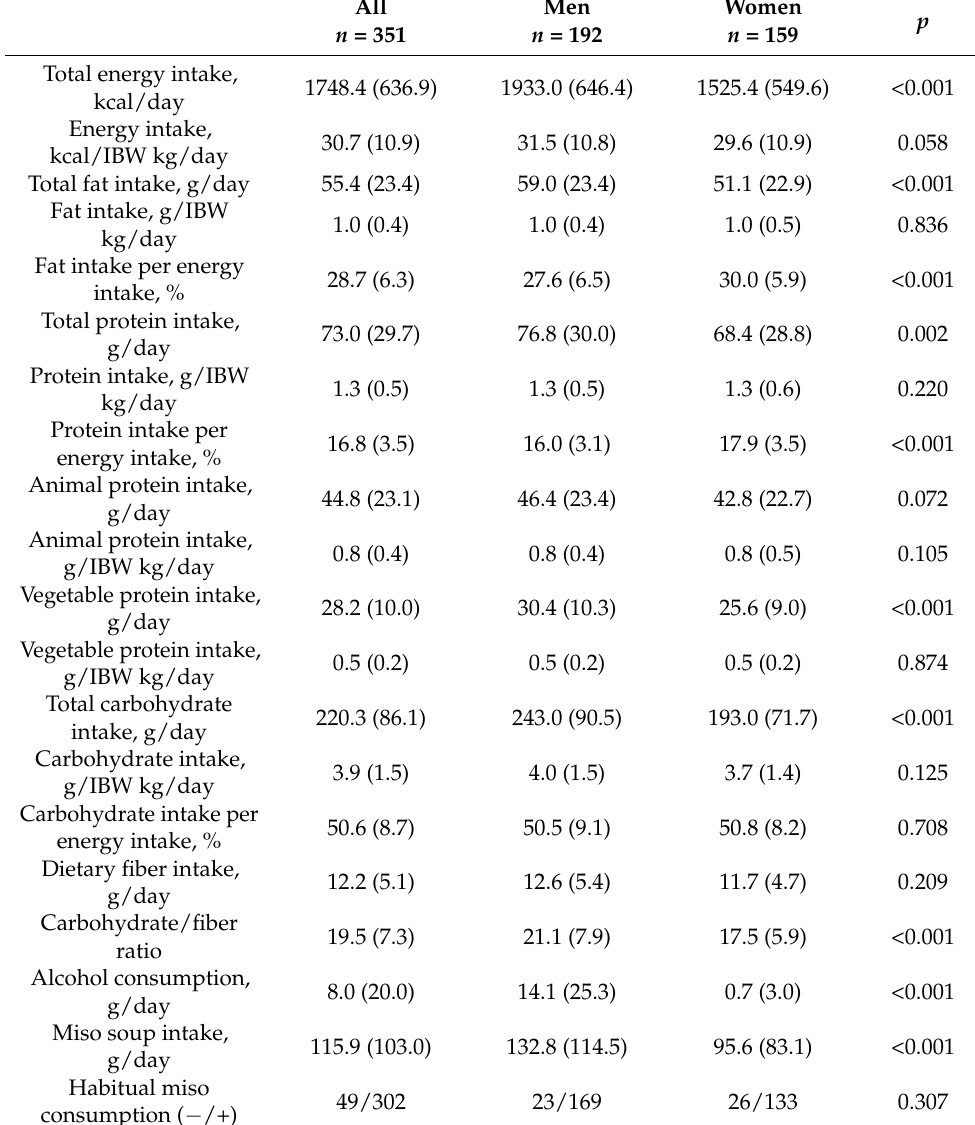
Table 2. Habitual diet intake of study participants.